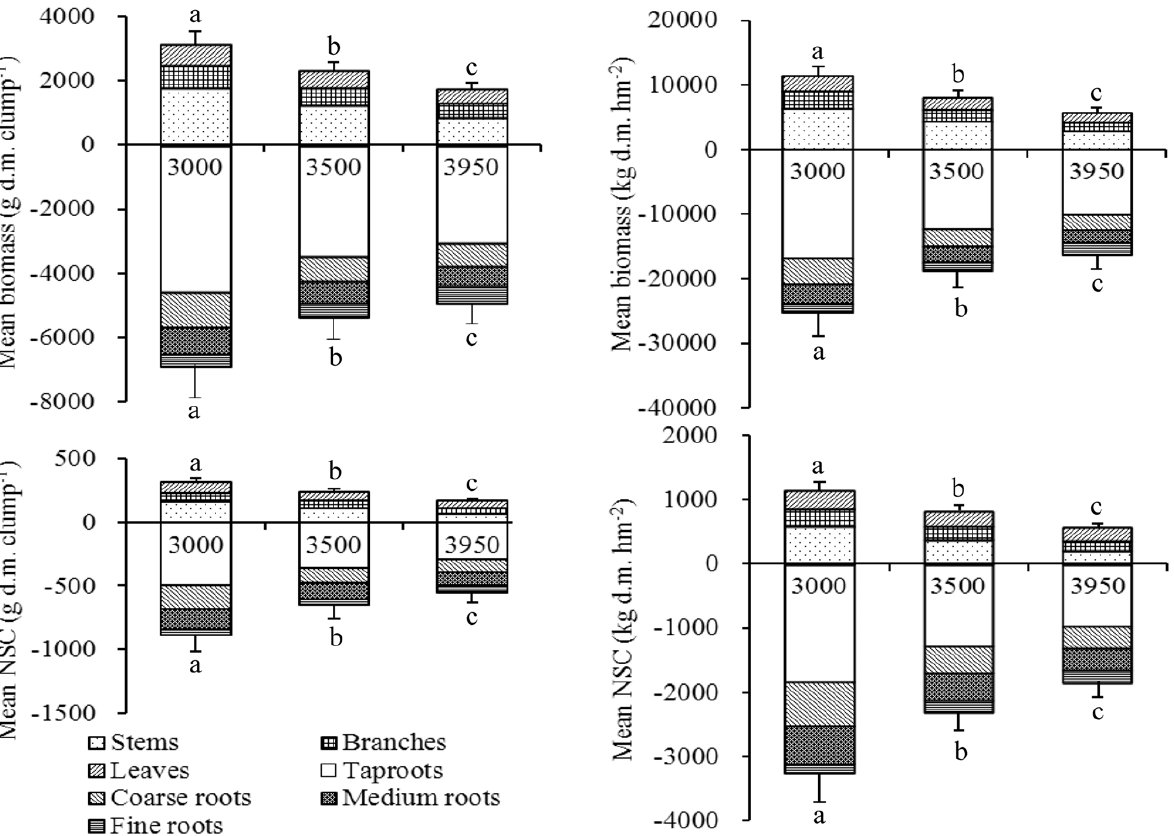
Figure 4. Mean biomass and pool size of non-structural carbohydrates (NSC) at individual and stand level (both n =6) of Quercus aquifolioides shrubs grown at 3000, 3500, and 3950 m a.s.l. on a SE-facing slope of Mt. Zheduo, SW China. Different letters indicate statistically significant differences ( p , 0.05) in biomass or NSC pool size among elevations. Standard errors bars ( + 1SE) are given for the total above- or below-ground biomass or the total above- or below-ground NSC pool